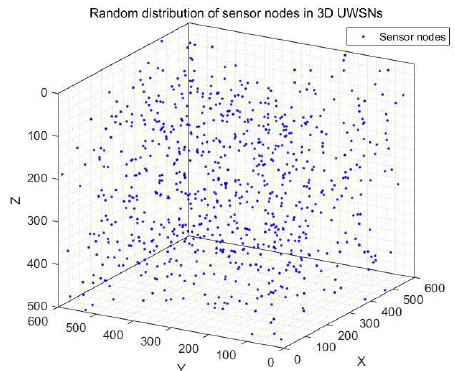
Figure 9. Random distribution of sensor nodes in 3D UWSNs.